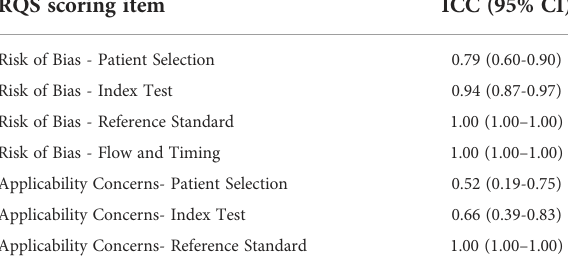
TABLE 5 Inter-rater agreement in QUADAS-2